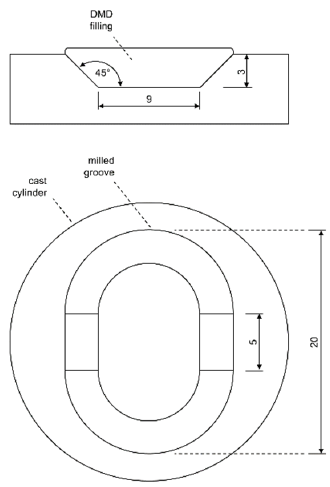
Figure 5. Dimensions of the groove geometry.